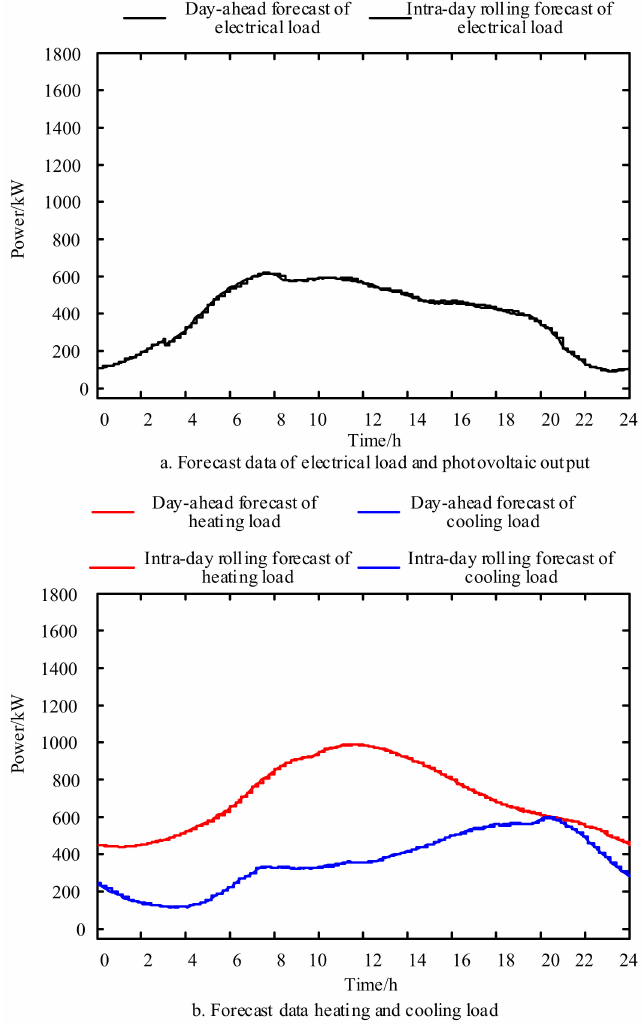
Figure A4. The day-ahead and intra-day forecast curves of PV and load output of the energy station